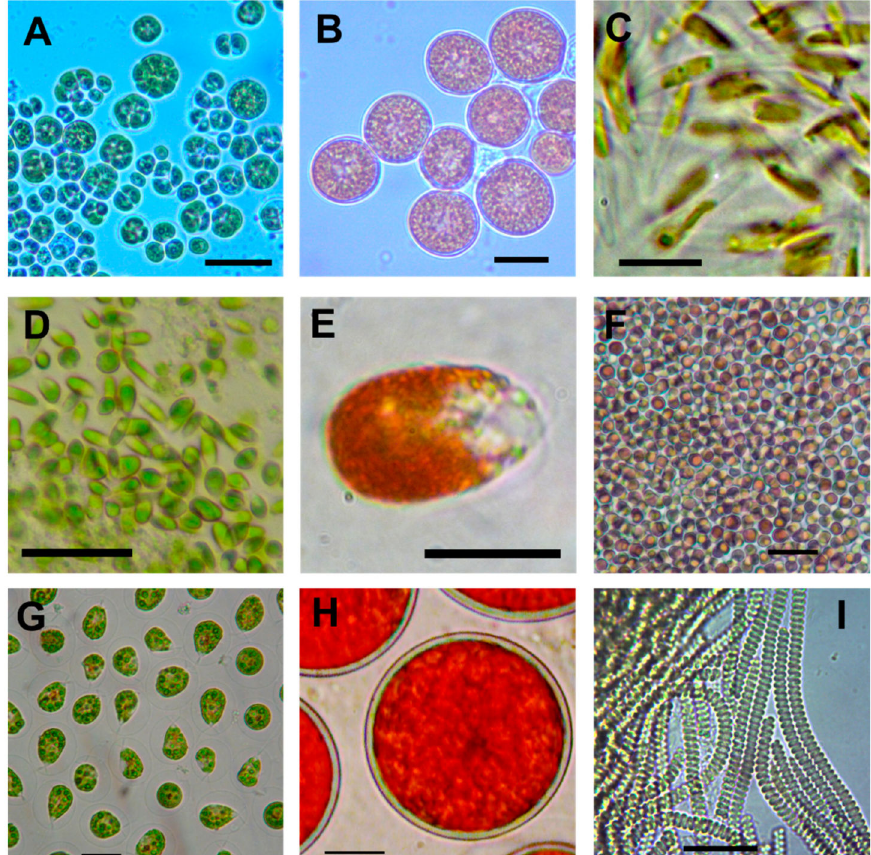
Figure 1. Light micrographs showing cellular colouration and morphological diversity of potential microalgae for commercial cultivation for various biotechnological applications. Chlorococcum sp. (( A , B ); source for mixed carotenoids including β -carotene, astaxanthin, canthaxanthin, lutein), Dunaliella salina (( D , E ); the source for β -carotene) and Haematococcus pluvialis (( G , H ); the source for astaxanthin) are cultivated as two distinct growth phases: (1) green-phase ((A,D,G); for biomass generation) and (2) stress-phase ((B,E,H); for carotenoids and fatty acids accumulation). ( C ), Phaeodactylum tricornutum (the source for essential fatty acid EPA), ( F ), Porphyridium cruentum (source for natural pink colourant phycoerythrin and bioactive polysaccharides) and ( I ), Arthrospira ( Spirulina ) sp. (source for natural blue colourant phycocyanin and multiple health benefitting ingredients) are cultivated as single-phase actively growing biomass for the targeted biomolecules. All scale bars are 25 µ m, except for (C,E), which are 10 µ